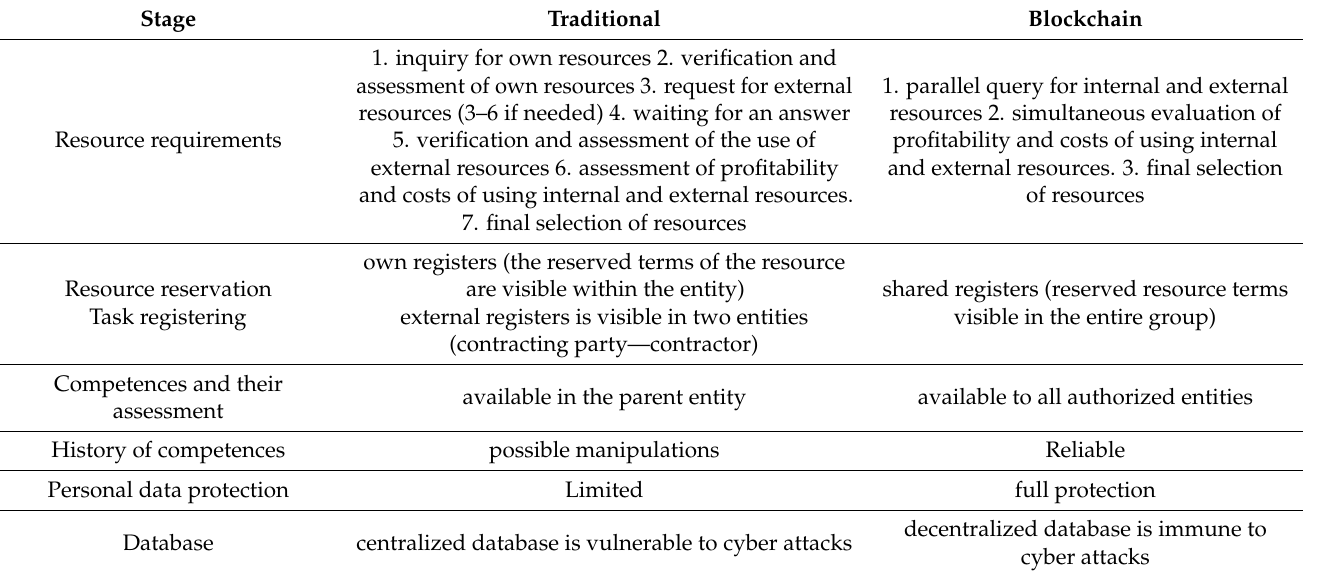
Table 3. Comparison of the flow of information on production tasks and employee competencies in the traditional and blockchain